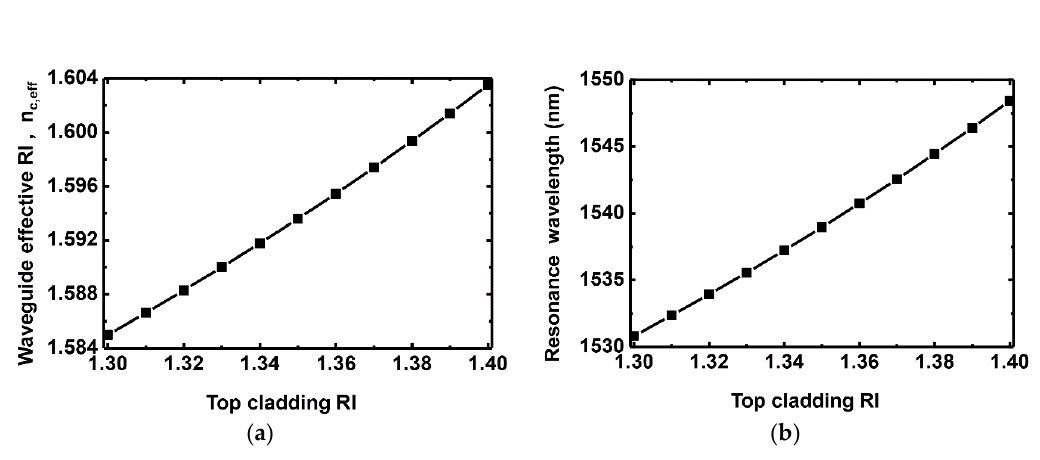
Figure 2. ( a ) Effective RI of the waveguide core and ( b ) resonance wavelength of a fringe mode as a function of the top cladding RI.